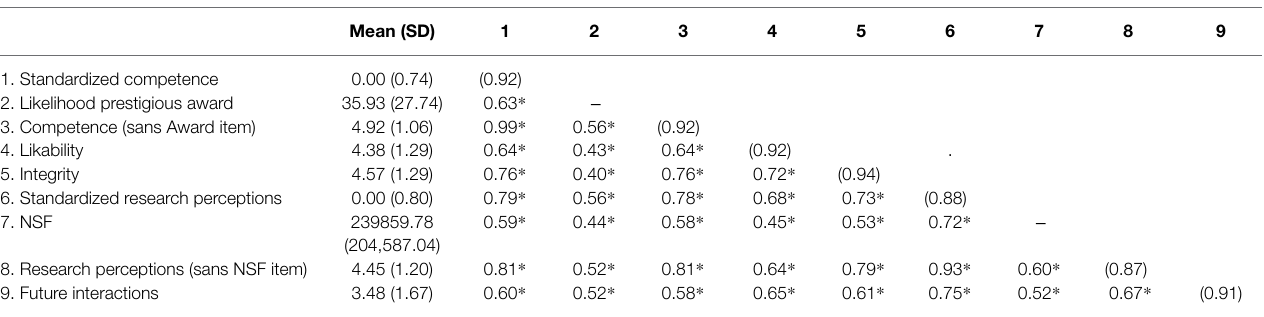
TABLE 1 | Descriptives and correlations among all outcomes in Study